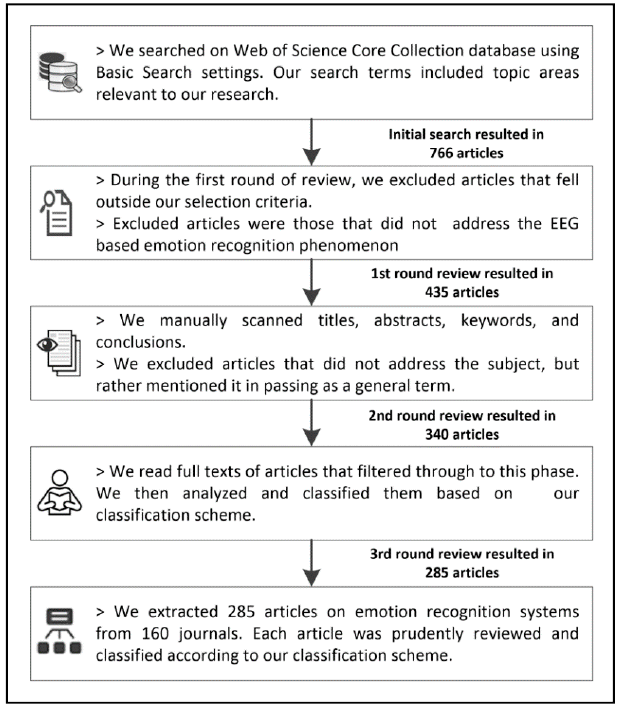
Figure 2. Procedure that we used to extract and filter articles.